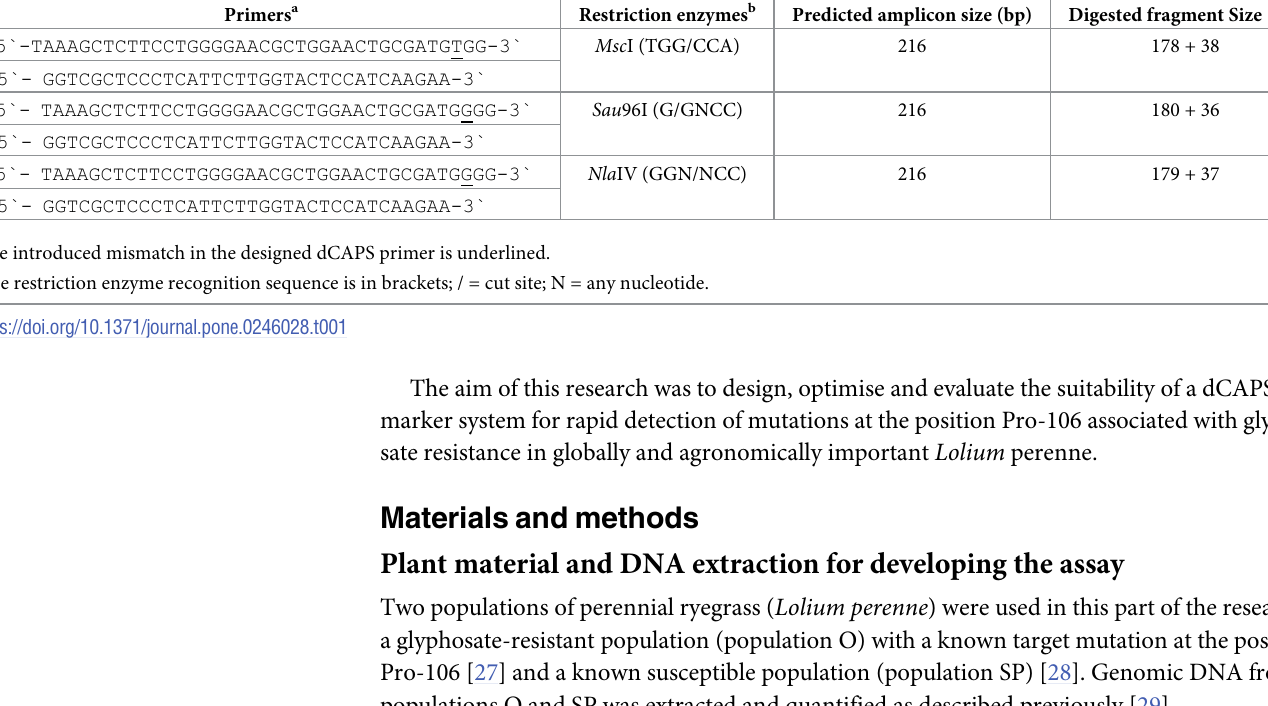
Table 1. dCAPS primers designed to detect target-enzyme mutation at position Pro-106 in EPSPS gene in Lolium perenne. Primers a